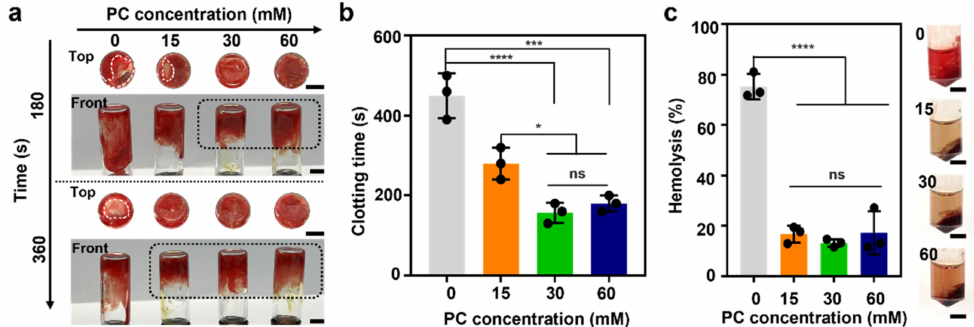
Figure 5. Blood compatibility of APC hydrogel. ( a ) Blood coagulation assays and ( b ) coagulation times of 0 mM(gray), 15 mM (orange), 30 mM (green), and 60 mM (blue) PC-containing APC hydrogels. Black and white dashed lines indicate clotting and non-clotting performance, respectively. Scale bar: 5 mm. n = 3. ( c ) Hemolytic activity evaluation of 0 mM (gray), 15 mM (orange), 30 mM (green), and 60 mM (blue) PC–containing APC hydrogels. ( n = 3) Scale bar: 5 mm. All statistical significance and p values are determined by one-way ANOVA followed by Tukey’s post-hoc test. * p < 0.05, *** p < 0.001, **** p < 0.0001; ns denotes not